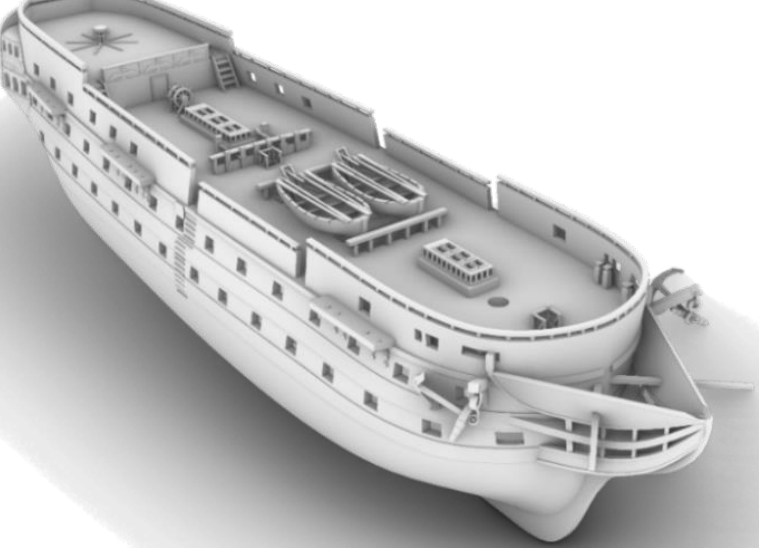
Figure 3 . Hull, deck, and deck details (lifeboats, deck hatch covers, etc.). 3D models created in Rhino3D.